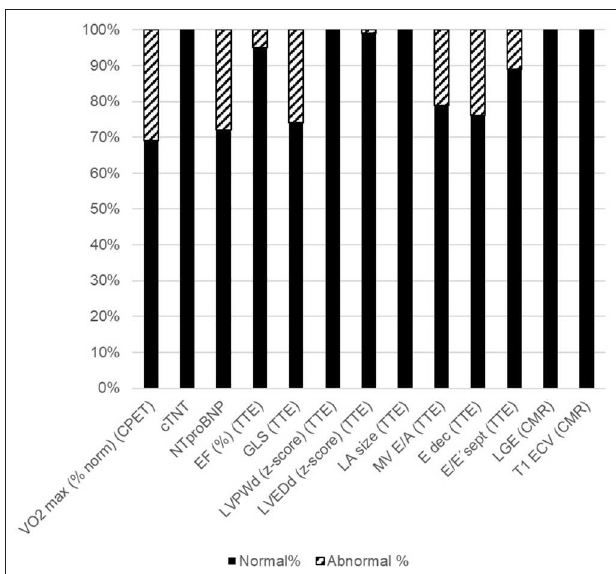
FIGURE 1 | Abnormal cardiovascular parameters. Shown are the percentages of childhood cancer survivors with normal cardiovascular parameters (black bars) and those with abnormal cardiovascular parameters (striped bars). Please see methods section for cut-off values. CPET: cardiopulmonary exercise testing; VO 2 max (% norm): peak respiratory oxygen uptake in % predicted; EF, Ejection Fraction; GLS, Global longitudinal strain; LVPWd, Enddiastolic left ventricular posterior wall dimension; LVEDd, Left ventricular enddiastolic diameter; LA, left atrium; MV, Mitral valve; CMR, cardiovascular magnetic resonance imaging; LGE, Late gadolinium enhancement; ECV, extracellular volume fraction.